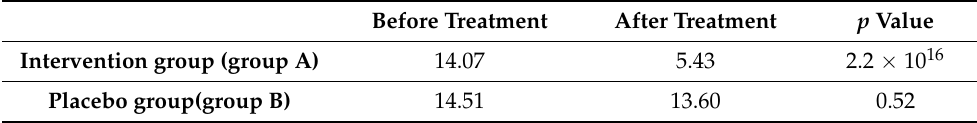
Table 3. Nasal Symptoms Score (NSS) in the study population. Before